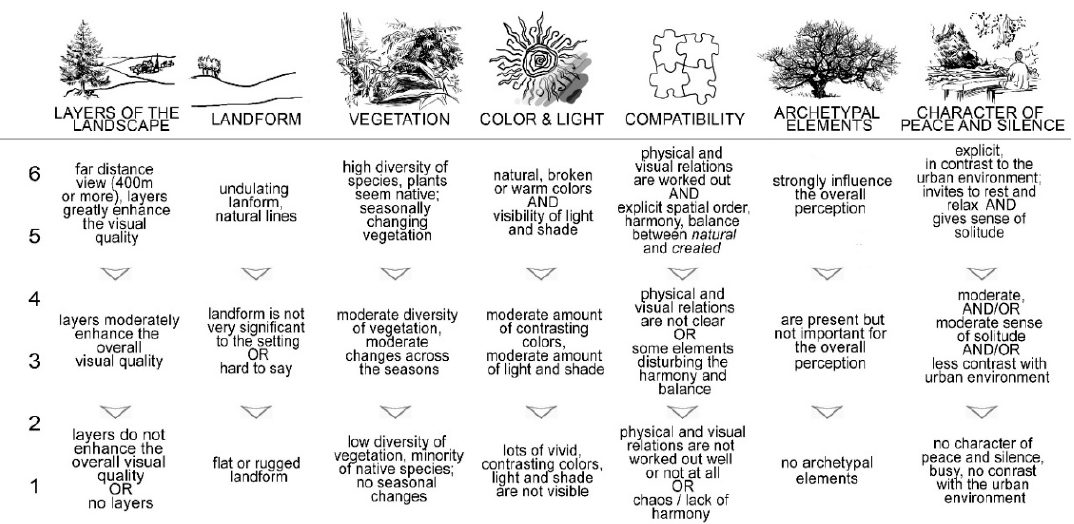
Figure 1. Simplified Contemplative Landscape Model for built landscape evaluation with 1 to 6-point scoring scale; adapted from [22] .